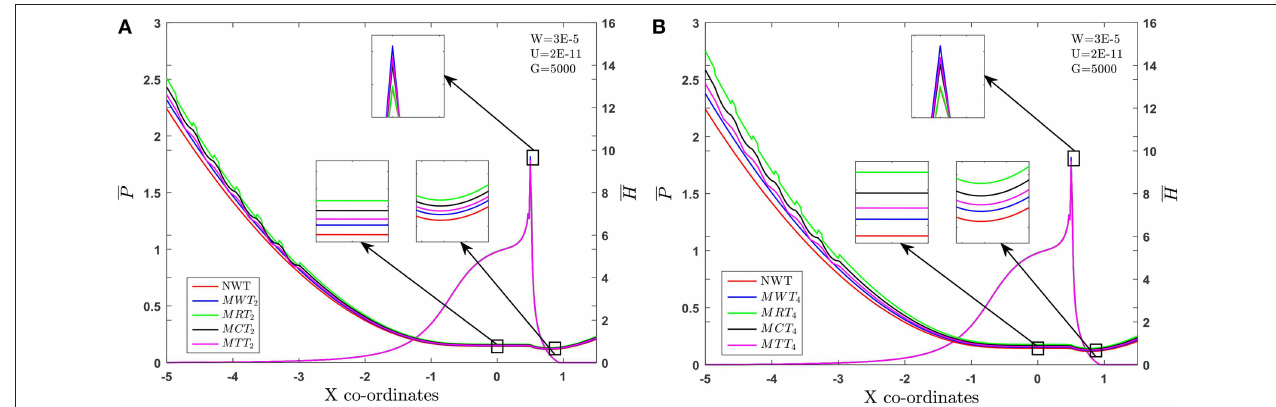
FIGURE 7 | Combined effect of Hm (A) 2, (B) 4, and micro textures shapes in inlet zone for W = 3 E − 5.